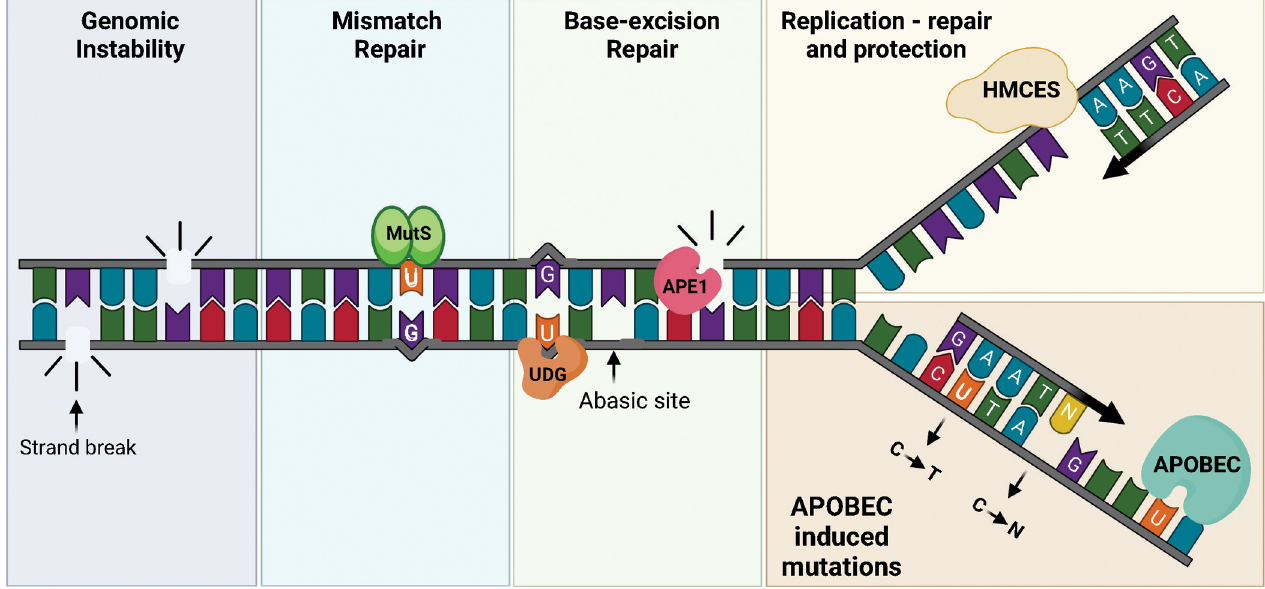
Fig 1. Cellular processing of AID/A3-induced genomic uracils. Schematic of deaminase enzymes targeting single-stranded DNA in the progressing replication fork and the fate of the genomic uracils. AID targets single-stranded DNA in transcription bubbles resulting in U:G mismatches recognized by mismatch repair (MutS; blue panel) or base excision repair (UDG; green panel). UDG excises uracil resulting in an abasic site that is cleaved by APE1. If uracils were present in close proximity and in both strands, cleavage of the DNA backbone by APE1 will induce genomic instability (purple panel). The A3 proteins target cytosines in progressing replication forks. Copying over the resulting uracil will result in a C to T transition mutation (orange panel). UDG can also travel with the replication machinery and excise the uracil, resulting in an abasic site. Abasic sites can be bypassed by translesion synthesis polymerases resulting in a C to N (any nucleotide) mutation (orange panel). Alternatively, HMCES can crosslink the abasic site (yellow panel), halting the progression of replication and protecting the DNA from strand breaks until appropriate repair machinery is recruited. AID AU : AbbreviationlistshavebeencompiledforthoseusedinFigs 1 and 2 : Pleaseverifythatallentriesarecorrect : , activation-induced cytosine deaminase; APOBEC, apolipoprotein B mRNA editing catalytic polypeptide; HMCES, 5-hydroxymethylcytosine-binding ES cell-specific protein; UDG, uracil-DNA glycosylase; APE1, apurinic/apyrimidinic endonuclease 1.